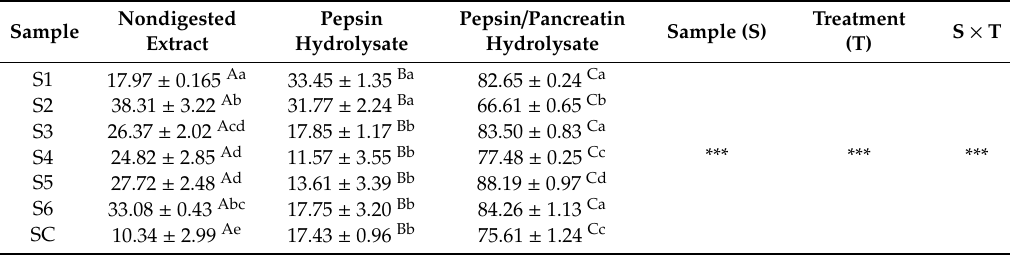
Table 5. Results of Fe 2 + chelating activity (%).